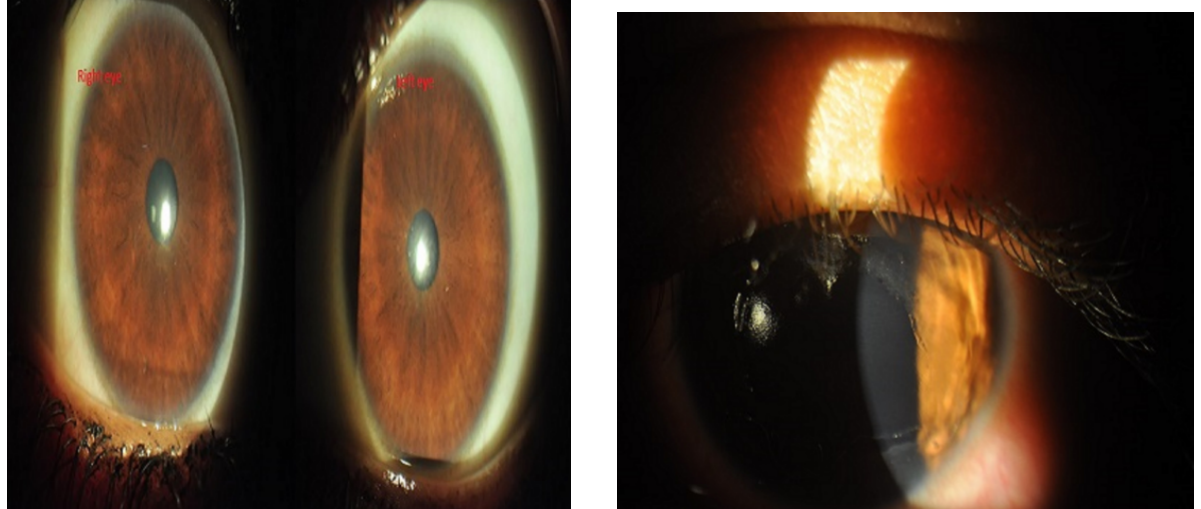
Figure 5: Slit lamp photo after scrapping of